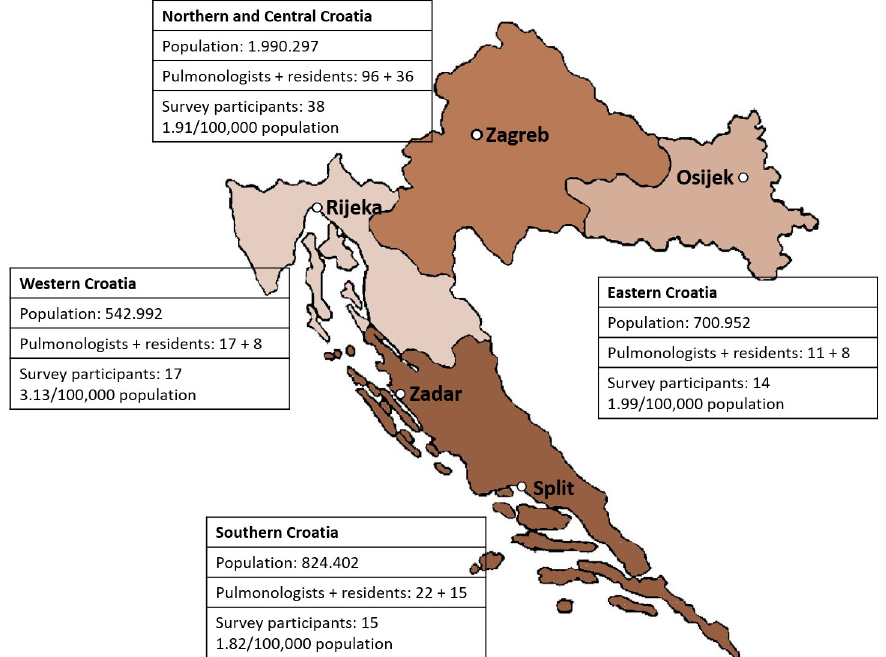
Fig 2. The regional distribution of surveyed pulmonologists. Distribution is shown in relationship to administrative regional division of Croatia into four regions: Northern and Middle, Western, Eastern, and Southern, including data about population, and number of pulmonologists and residents [14, 15]. This also corresponds with location of referral centers for severe asthma in Croatia (two centers in Zagreb, one at Split, Rijeka, Zadar, and Osijek). Reprinted with permission from Kay Square Press,